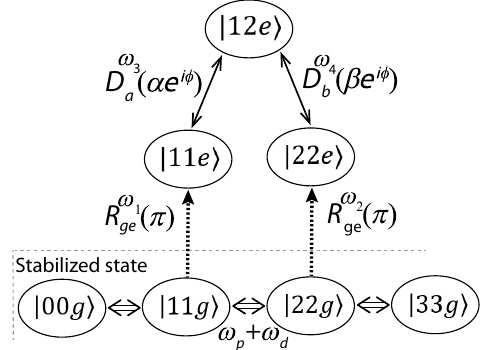
FIG. 10. A visual depiction of the pulse sequence used for the subspace tomography to determine the ρ 11,22 element while tracking the | 12 (cid:2) state as a specific example. The